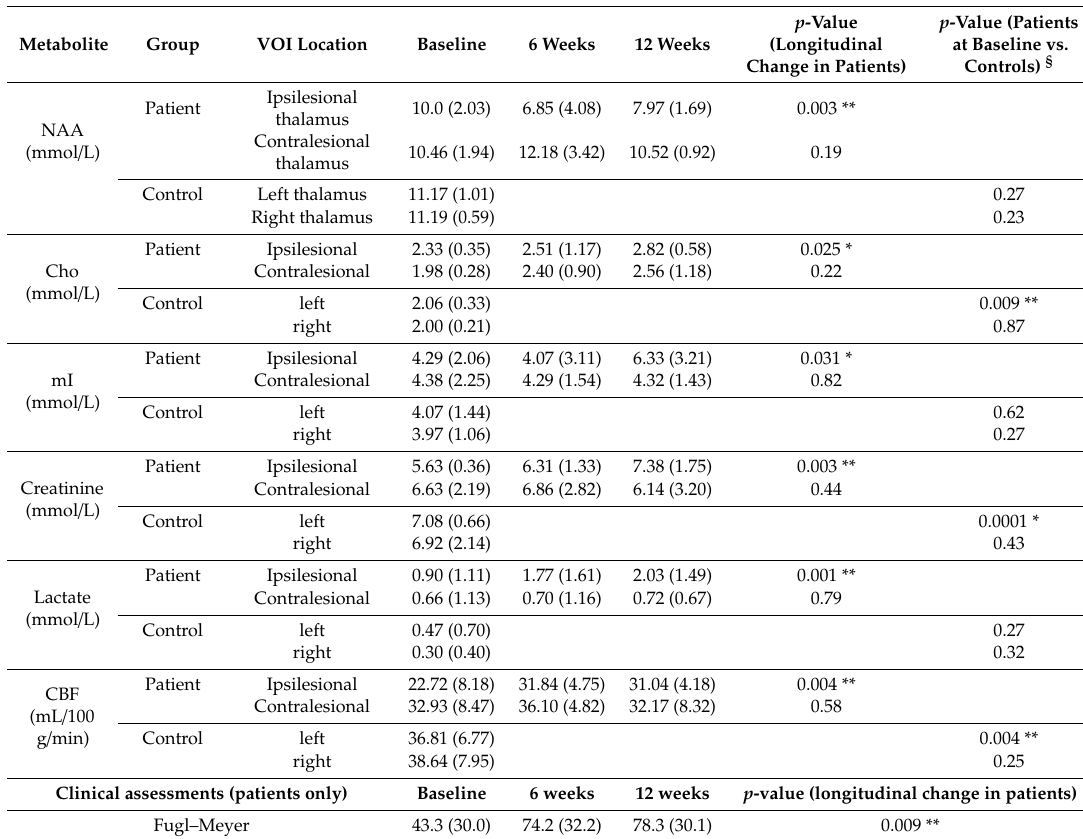
Table 1. Longitudinal changes in the mean concentration of metabolites (measured as mmol / L) and regional perfusion in the intact ipsilesional and contralesional thalamus between 2 and 12 weeks post-stroke.